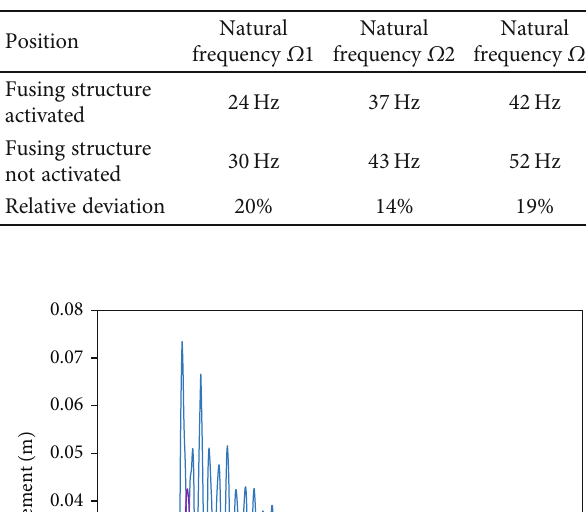
Table 6: Natural frequency of a dual-rotor system with varied- sti ff ness fusing structure.